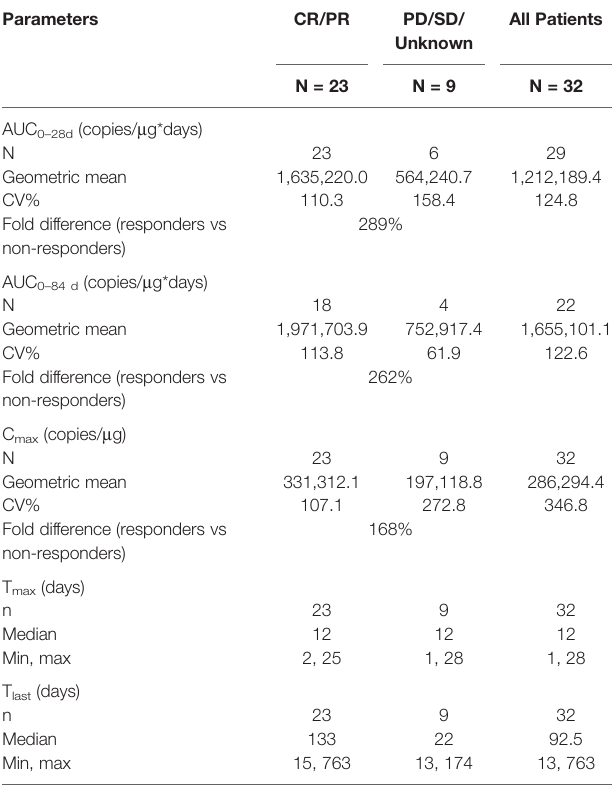
TABLE 3 | Summary of cellular kinetic parameters strati fi ed by response.